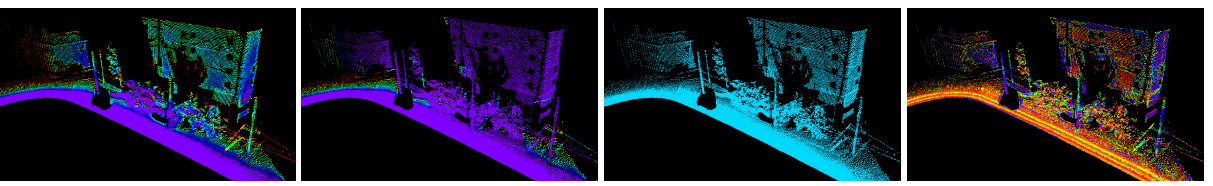
Figure 4. Number of points within the local neighborhood when using the neighborhood types N s, 1m , N c, 1m , N k =50 and N k left to right): the color encoding indicates neighborhoods with 10 or less points in red and reaches via yellow, green, cyan and blue to violet for 100 and more points.